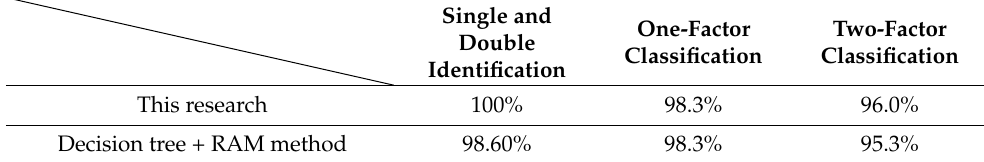
Table 14. Overall classification accuracy comparison.